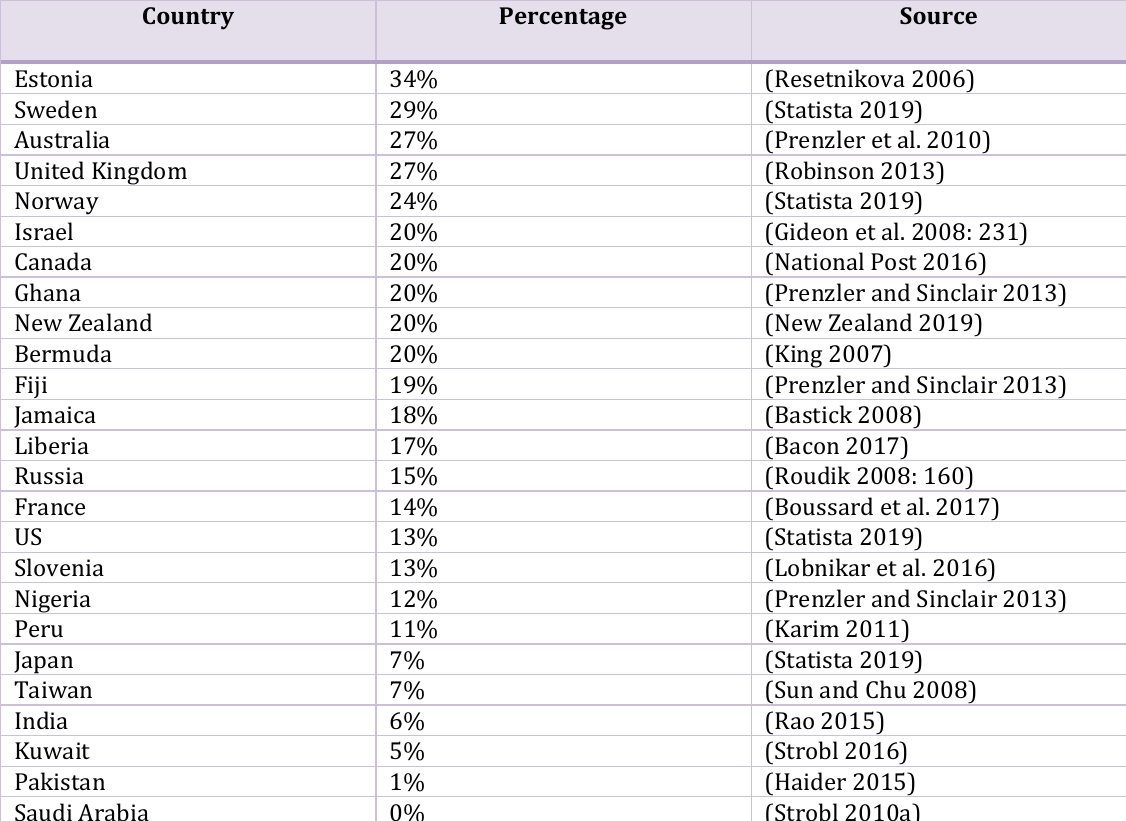
Table 1: Percentage of women police officers in national police forces Country Percentage